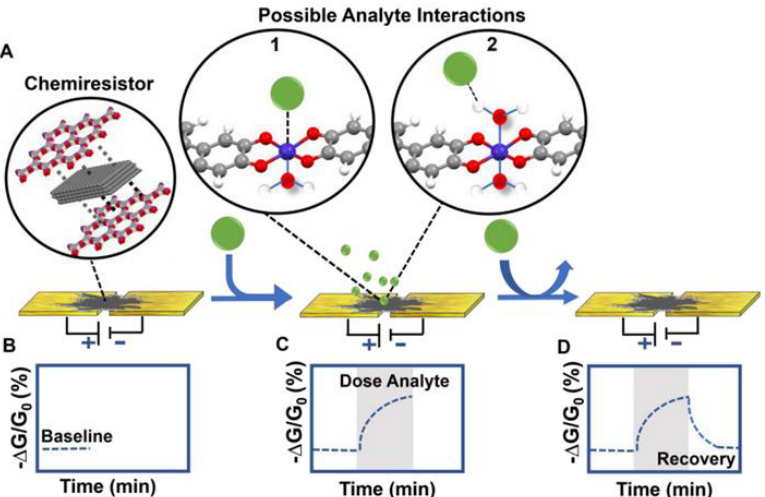
Figure 6. Chemiresistive—based MOF gas sensors sketch, reproduced from Ref. [181]. ( A ) the sensing layer completes a circuit by bridging two electrodes. ( B ) baseline. ( C ) The analyte (green circle) interacting with the sensing layer leads to a change in conductance coincident with analyte binding. ( D ) Recovery phase.